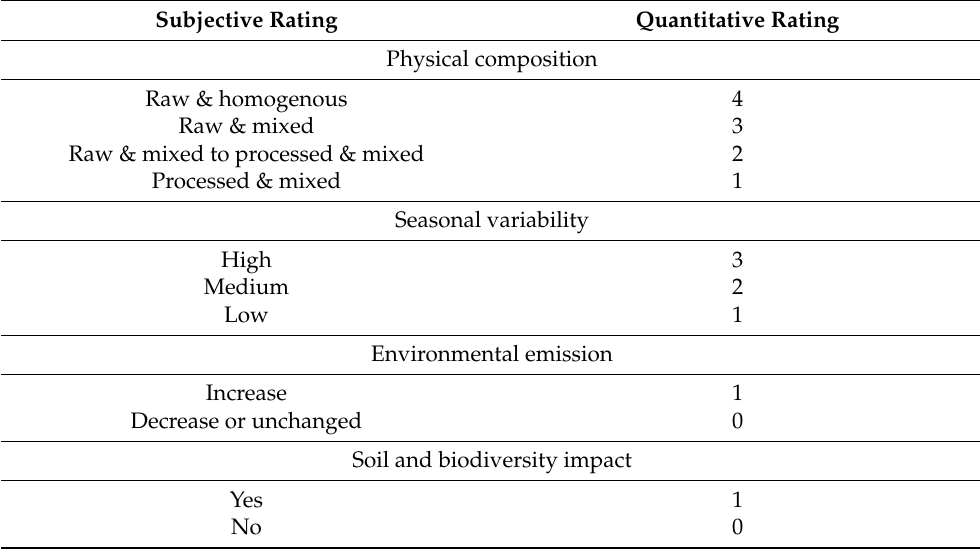
Table 4. Scales used for quantitative estimation of subjective